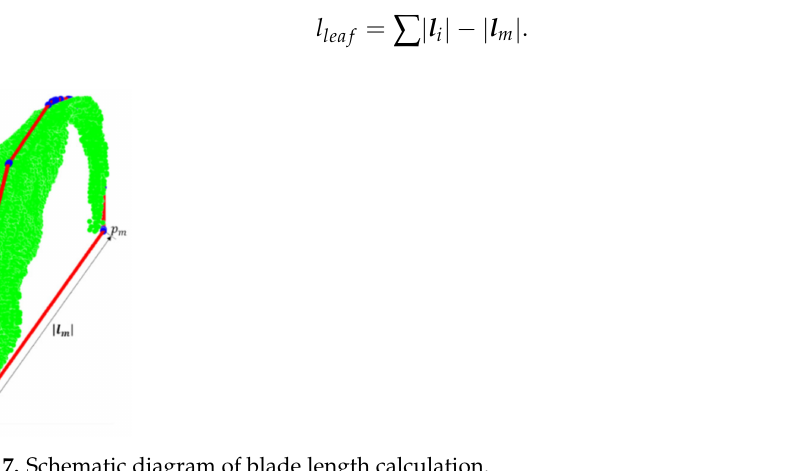
Figure 7. Schematic diagram of blade length